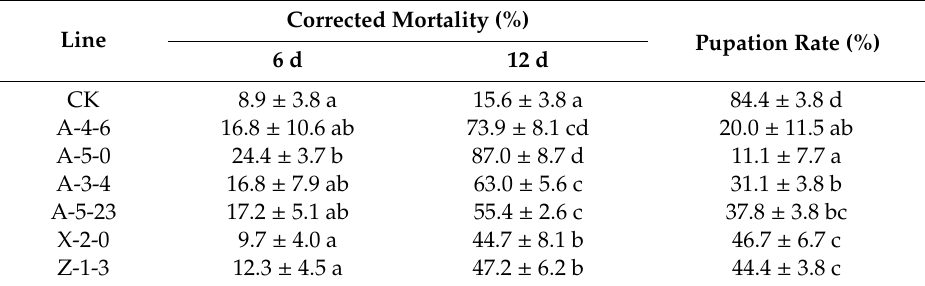
Table 3. Insecticidal activity of Bt transgenic poplar against Clostera anachoreta . Line